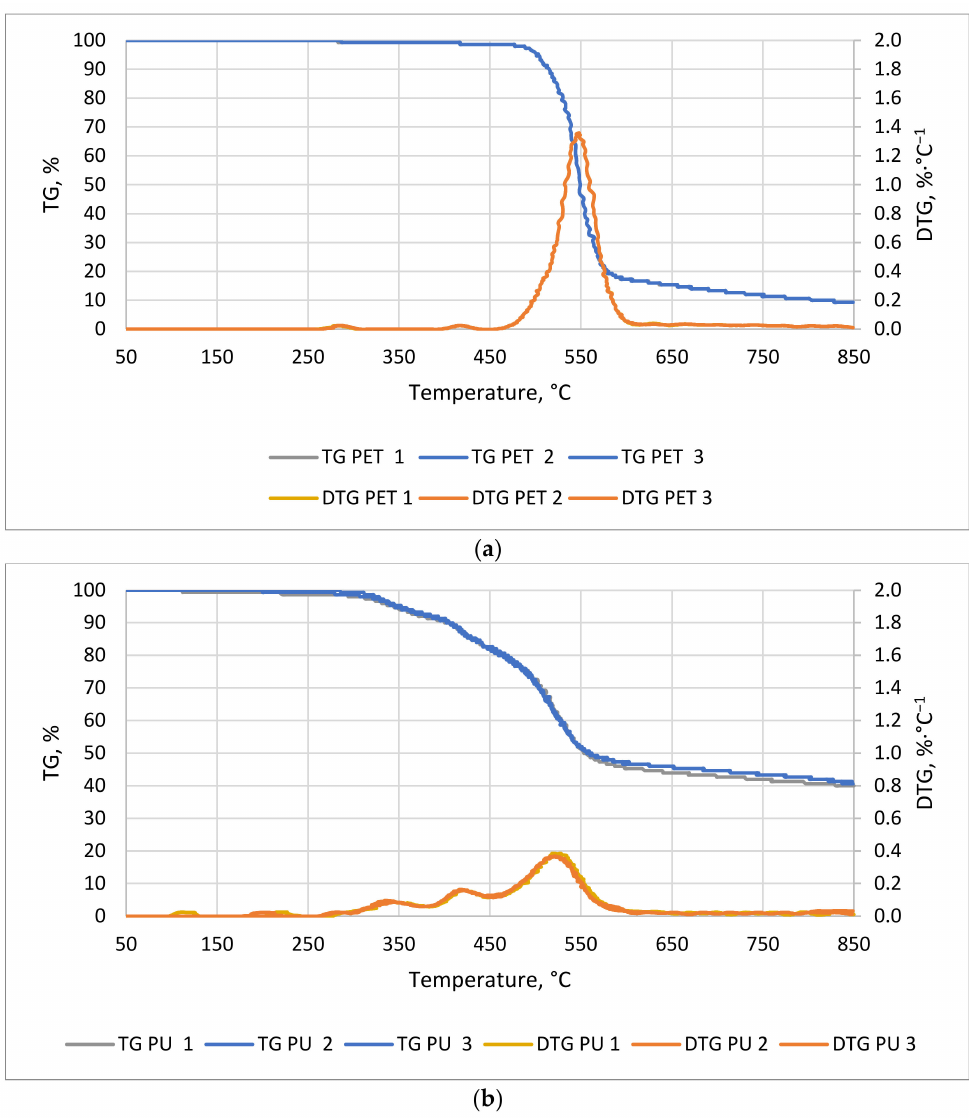
Figure 7. Characteristics of the TG/DTG of plastic waste: ( a ) PET; ( b ) PU. For PU, seven transformations were recorded during DSC analysis (Figure